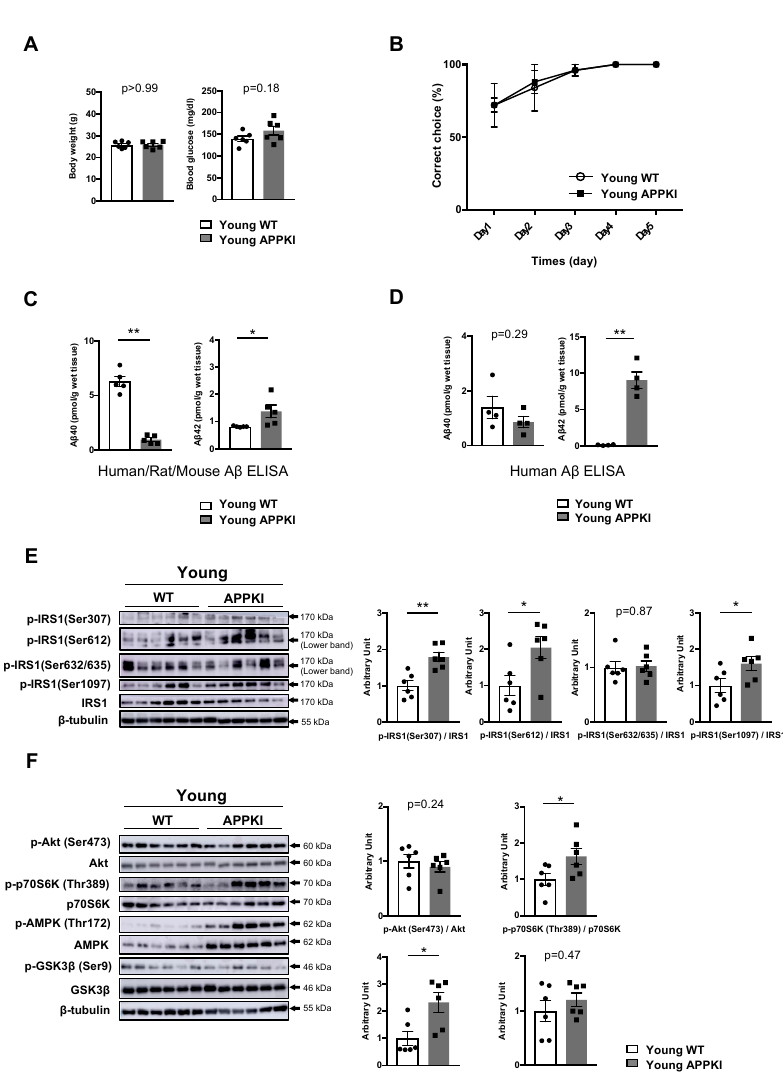
Figure 4. Activation of multiple Ser residues on hippocampal IRS1 unrelated to memory decline in young amyloid precursor protein (APP) knock-in (APPKI NL-G-F ) mice. ( A ) The graphs of body weight and blood glucose levels in young wild-type (WT) and APPKI NL-G-F mice (12 weeks of age, n = 6 mice per group). ( B ) Evaluation of learning memory function in young WT (n = 5 mice per group) and APP KI NL-G-F mice (n = 5 mice per group) using the water T-maze test. ( C ) Quantitative analysis of T-PER-extractable A β 40 and A β 42 levels in the hippocampi of young WT and APPKI NL-G-F mice using the human / rat / mouse β amyloid (1–40 and 1–42) ELISA (12 weeks of age, n = 5 biologically independent samples per group). ( D ) Quantitative analysis of T-PER-extractable A β 40 and A β 42 levels in the hippocampi of young WT and APPKI NL-G-F mice using the human β amyloid (1–40 and 1–42) ELISA (12 weeks of age, n = 5 biologically independent samples per group). ( E ) Western blot analysis of phosphorylated insulin receptor substrates 1 mouse Ser307 [p-IRS1 (mSer307)], p-IRS1 (mSer612), p-IRS1 (mSer632 / 635), p-IRS1 (mSer1097), IRS1, and ß-tubulin in the hippocampi of young WT and APP KI NL-G-F mice (12 weeks of age, n = 6 biologically independent samples per group). Arrows indicate the p-IRS1 mSer612-corresponding band (lower band) and p-IRS1 mSer632 / 635-corresponding band (lower band) in ( E ). Quantitative analysis of the phosphorylation of IRS1 at mSer307, mSer612, mSer632 / 635, andmSer1097normalizedtotherespectivetotalproteincontents. ( F )Western blot analysis of phosphorylation levels of Akt Ser473, p70S6K Thr389, AMPK Thr172, and GSK3 β Ser9 as well as total protein levels of Akt, p70S6K, AMPK, GSK3 β , and ß-tubulin in the hippocampi of young WT and APPKI NL-G-F mice (12 weeks of age, n = 6 biologically independent samples per group). Quantitative analysis of phosphorylation of Akt Ser473, p70S6K Thr389, AMPK Thr172, and GSK3 β Ser9 normalized to the respective total protein contents. Results are presented as mean ± SEM, * p < 0.05; ** p <